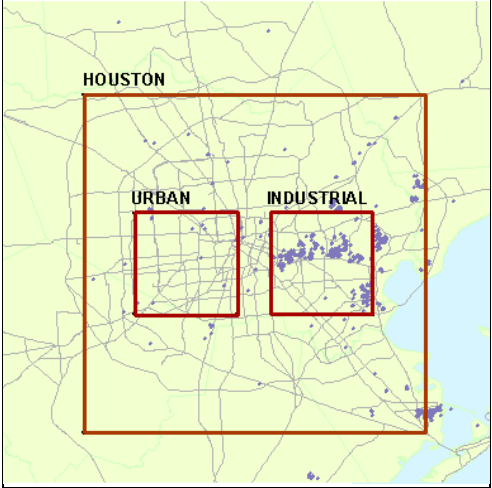
Figure 2. Starting locations of STOPS domains. Points indicate lo- cations of emission point sources in